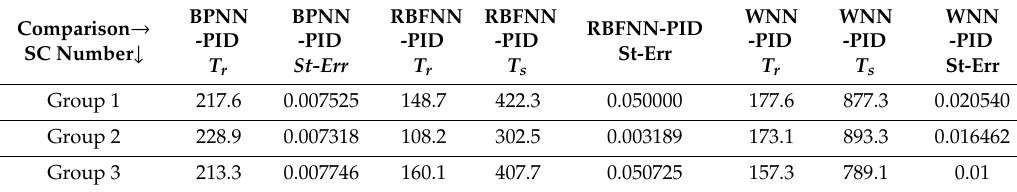
Table 8. Average results of the above three groups of simulations.